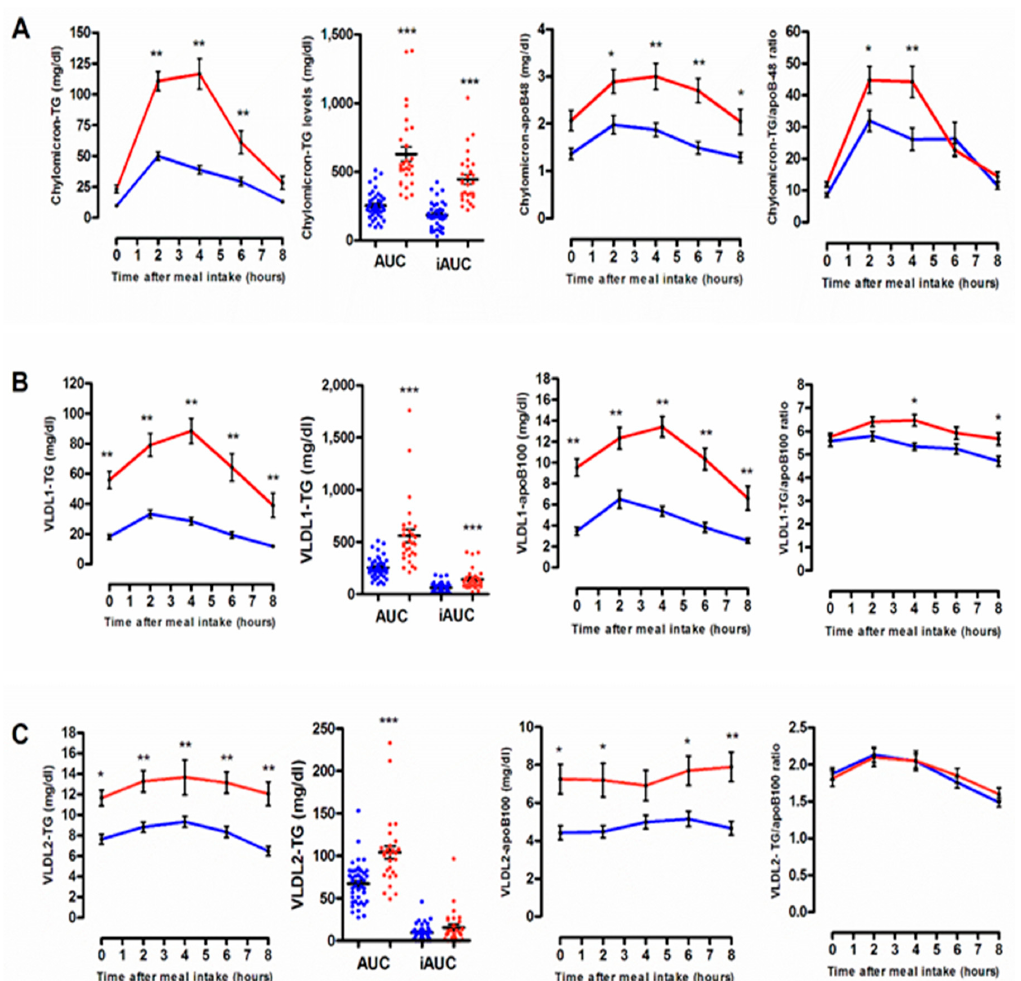
Figure 2. Postprandial time course of triglyceride-rich lipoprotein subfractions, chylomicrons ( A ), large very-low-density lipoprotein-1 (VLDL1) ( B ) and small VLDL2 ( C ) isolated from subjects from G Low (blue curve) and G High (red curve). In all sections are represented plasma levels of TRL-TG, area under the curve (AUC) and incremental AUC (iAUC) in subjects from G Low (blue dots) and G High (red dots), plasma levels of triglyceride-rich lipoprotein (TRL)-apoB and TRL-TG / apoB ratio. Values are mean ± SEM. *** p < 0.0001, ** p < 0.001 and * p < 0.05 versus G Low.